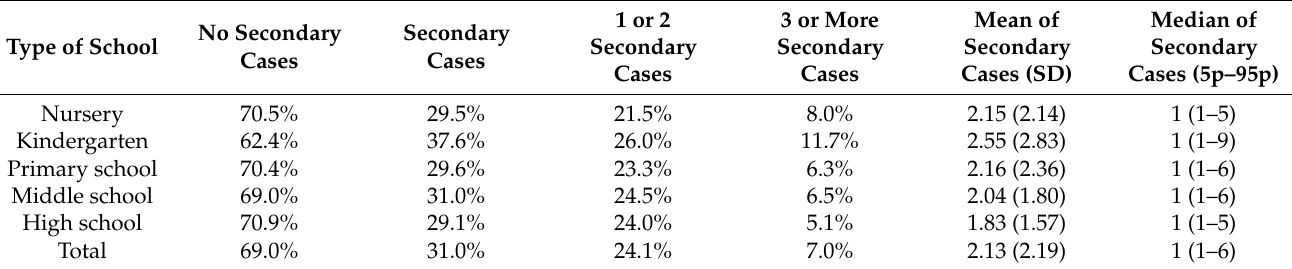
Table 2. Distribution of school-related secondary cases by type of school.